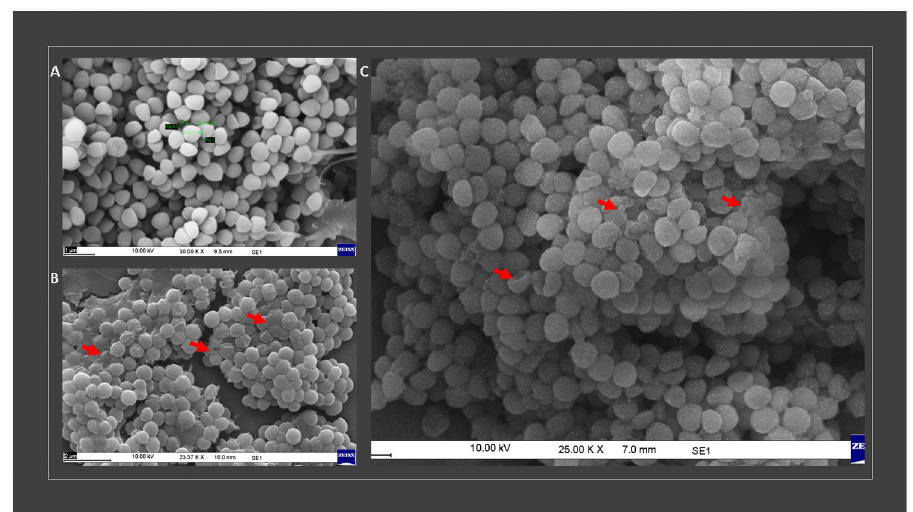
Fig 4. Effects of ethyl acetate extract on the ultrastructure of S . aureus and MRSA as observed by SEM (A, control; B, S . aureus ; C, MRSA).